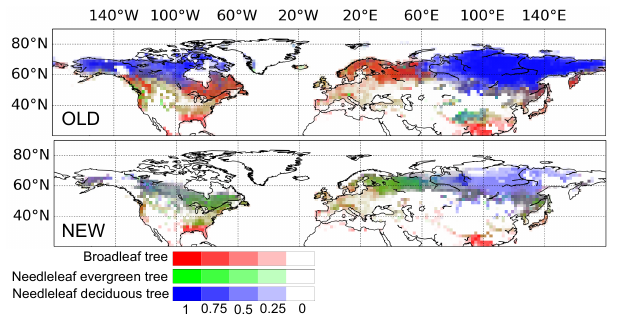
Figure 4. Composite color map of the fractional vegetation cover in OLD and NEW. Color indicates the fraction of three PFT groups: broadleaf (including evergreen and deciduous, red), needleleaf ever- green (green), and needleleaf deciduous (blue) trees. Deeper colors represent higher fractional